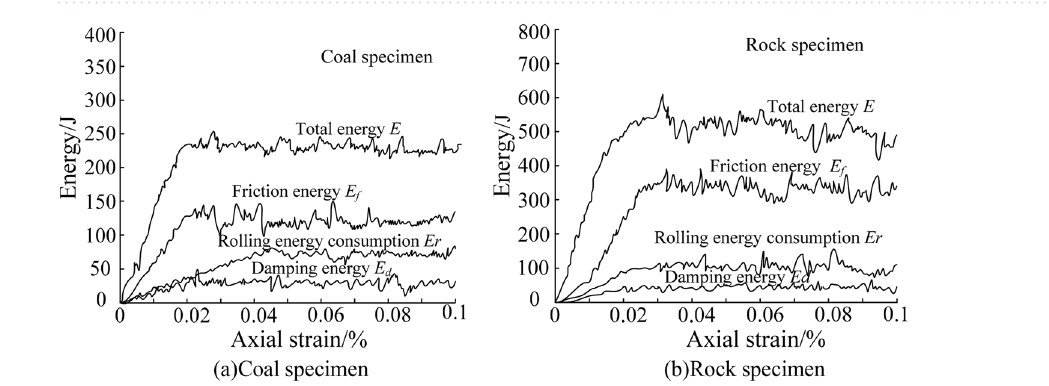
Figure 9. Relationship between dissipated energy and axial strain of